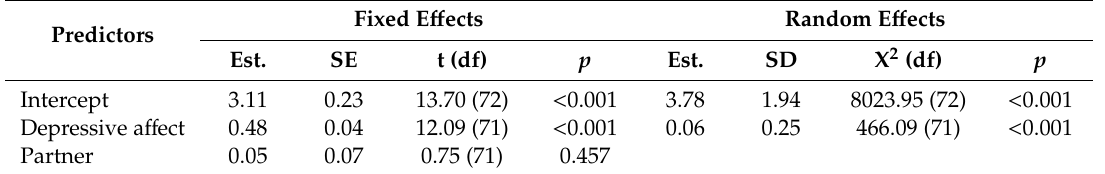
Table A5. Parameter estimates for multilevel model